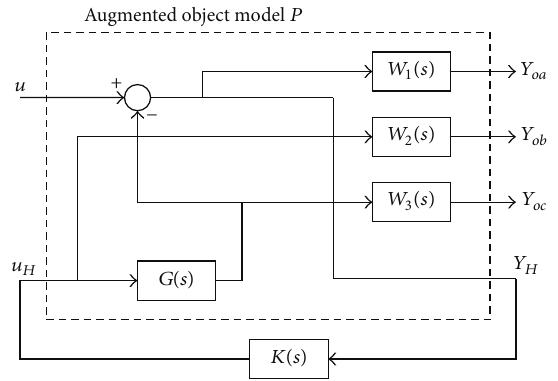
Figure 2: Double ports block diagram structure of H 2 control